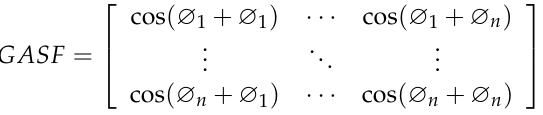
Figure 3. Candlestick chart of Cleveland in 2015/2016 and 2016/2017.